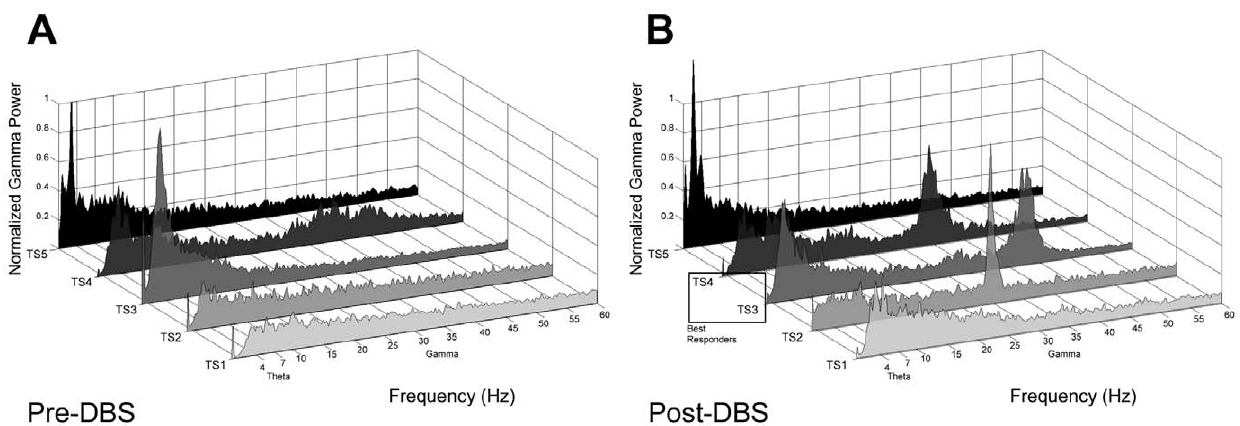
Figure 3. Changes in band specific power following DBS. A) Representative power spectra from all subjects in month 1 post-operatively. Recordings were taken before DBS was administered. B) Power spectra from all subjects late in the study (Months post-op for TS1=14, TS2 & TS4=5, TS3 and TS5=6). Months were chosen to represent the maximum gamma power. Changes in frequencies after prolonged DBS therapy are most prominent in the gamma range. All recordings taken from channel 4 (across contacts 1 and 4) in the right hemisphere in subjects with two unilateral devices or channel 1 (across contacts 1 and 2) in subjects with a single bilateral device.